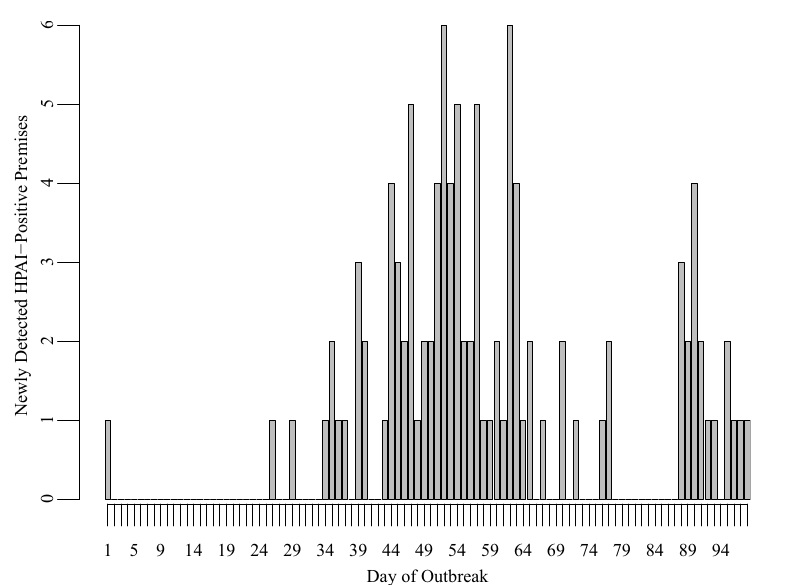
Fig 2. Number of premises newly detected with HPAI H5N2 per day during the 2015 outbreak in Minnesota. The absence of any new detections beginning the 78 th day and lasting through the 87 th day following the first detection was used to define two outbreak